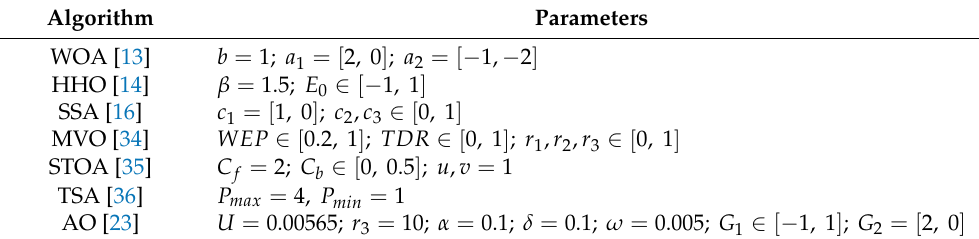
Table 4. Parameter settings for the optimization